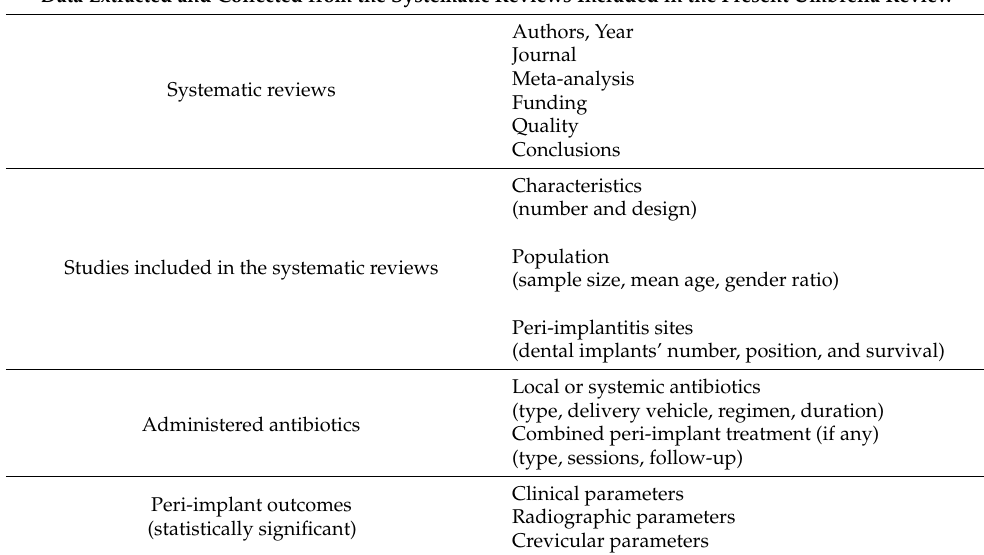
Table 1. Data extracted and collected from the systematic reviews included in the present umbrella review. Data Extracted and Collected from the Systematic Reviews Included in the Present Umbrella Review